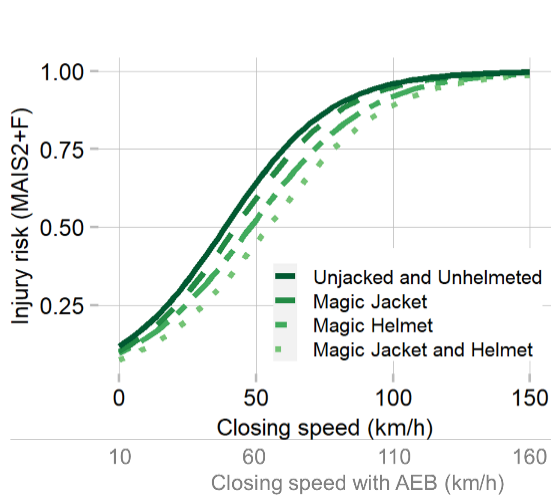
Figure 8. The injury risk-reducing effect of protective equipment for